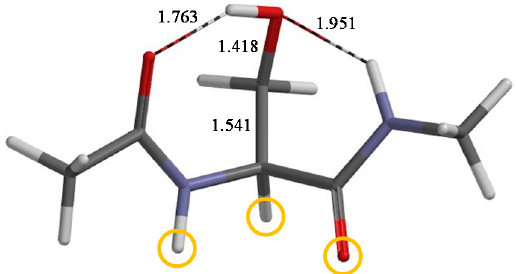
Figure 2. A conformer of the model compound shown in Figure 1 optimized by the B3LYP/6-31+G(d,p) method ( ϕ = 91 ◦ , ψ = − 124 ◦ , χ 1 = 80 ◦ , χ 2 = − 63 ◦ ). Selected interatomic distances are shown in Å. This conformer can interact with an H 2 PO 4 − ion at the three points indicated by orange circles and is reactive for the H 2 PO 4 − -catalyzed enolization. Grey: carbon; white: hydrogen; blue: nitrogen; red: oxygen.